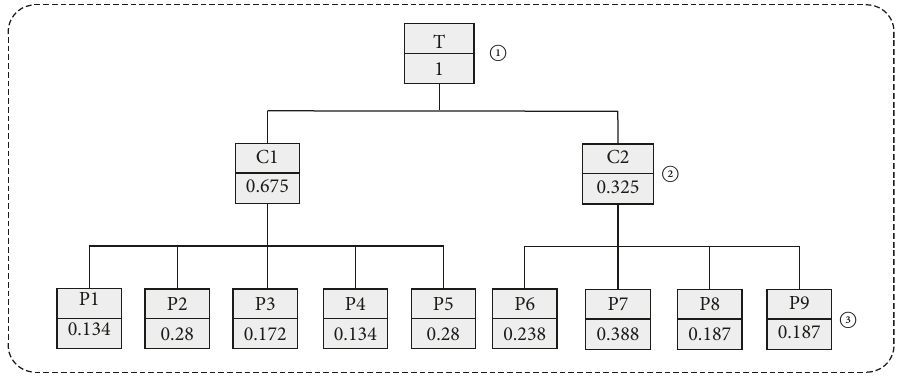
Figure 2: Hierarchical structure and weight assignment of assessment factors.